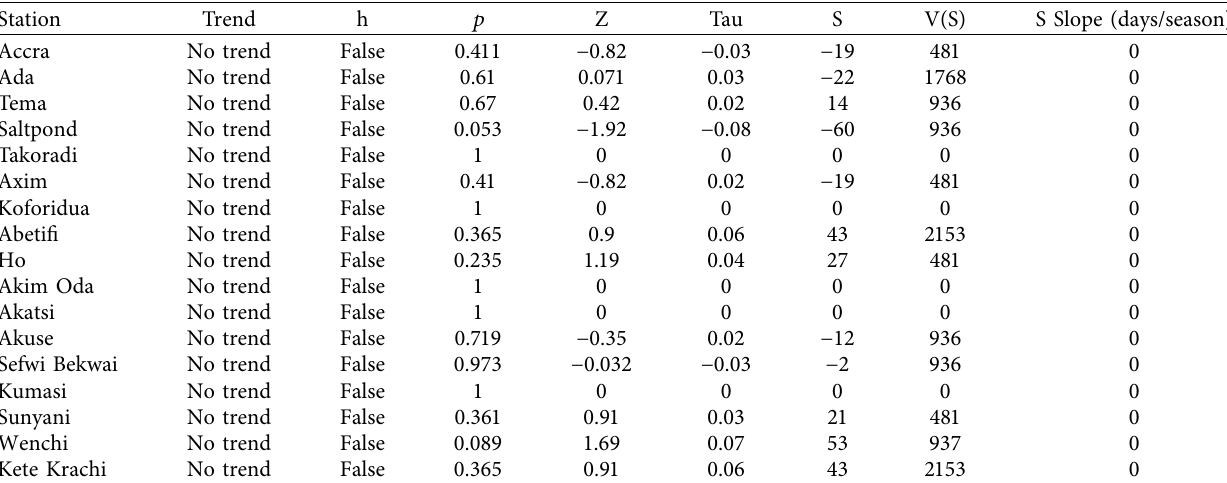
Table 8: Mann-Kendall trend results for the number of Very Wet Days